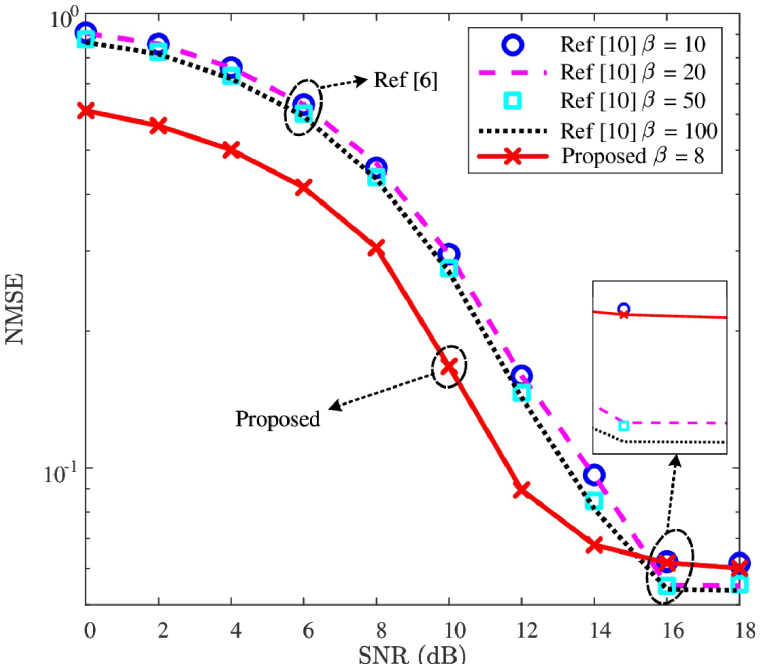
Fig 8. NMSE versus SNR, where P = 512, c = 2.0, and ρ = 0.10 are